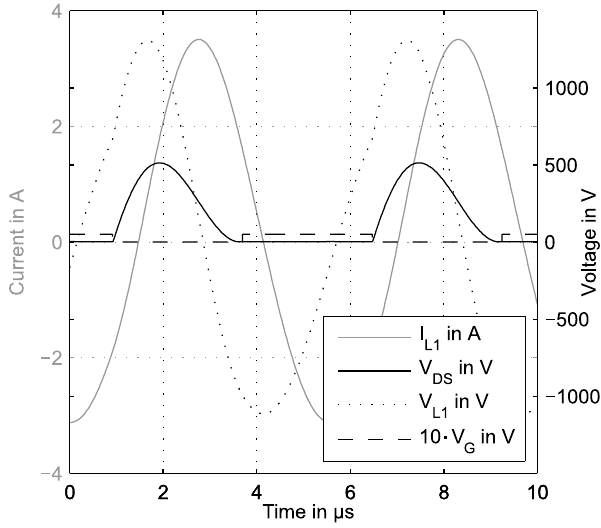
Figure 10. Simulation results for amplifier